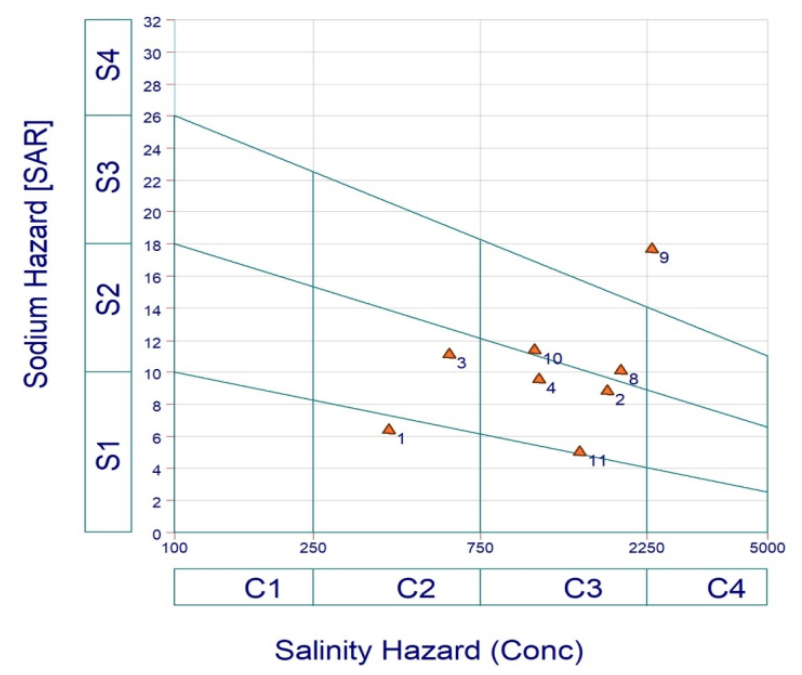
Figure 5. Classification of groundwater samples on the basis of electric conductivity and percent sodium [65].